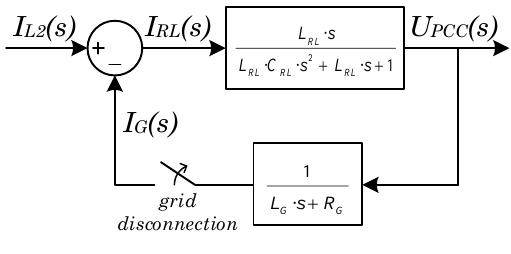
Figure 8. Bloc diagram of the PCC impedance transfer